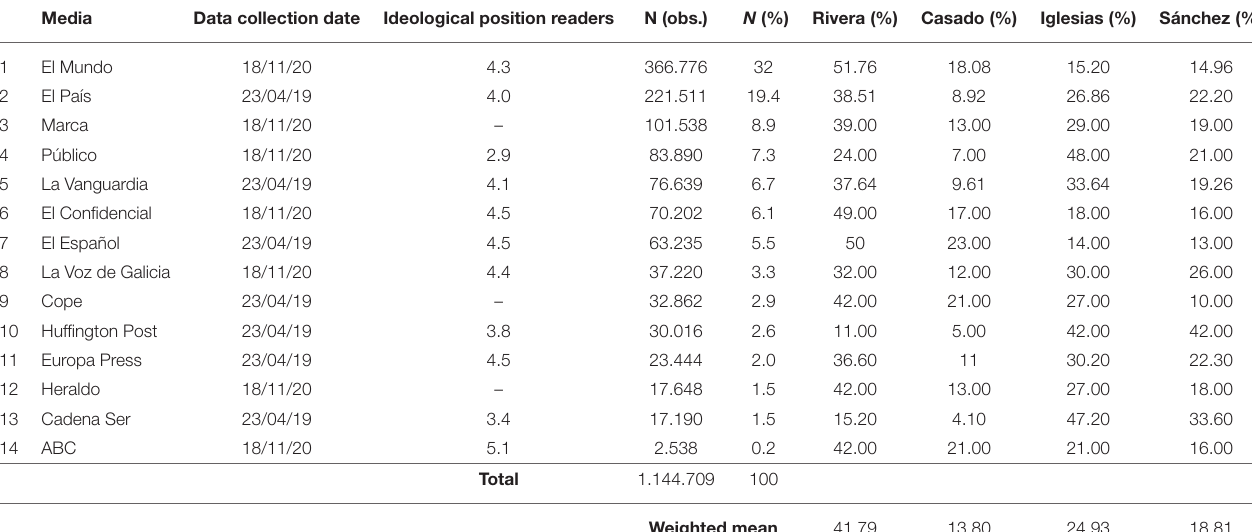
TABLE 5 | Opinions about the winner of the debate considering the main media in Spain.